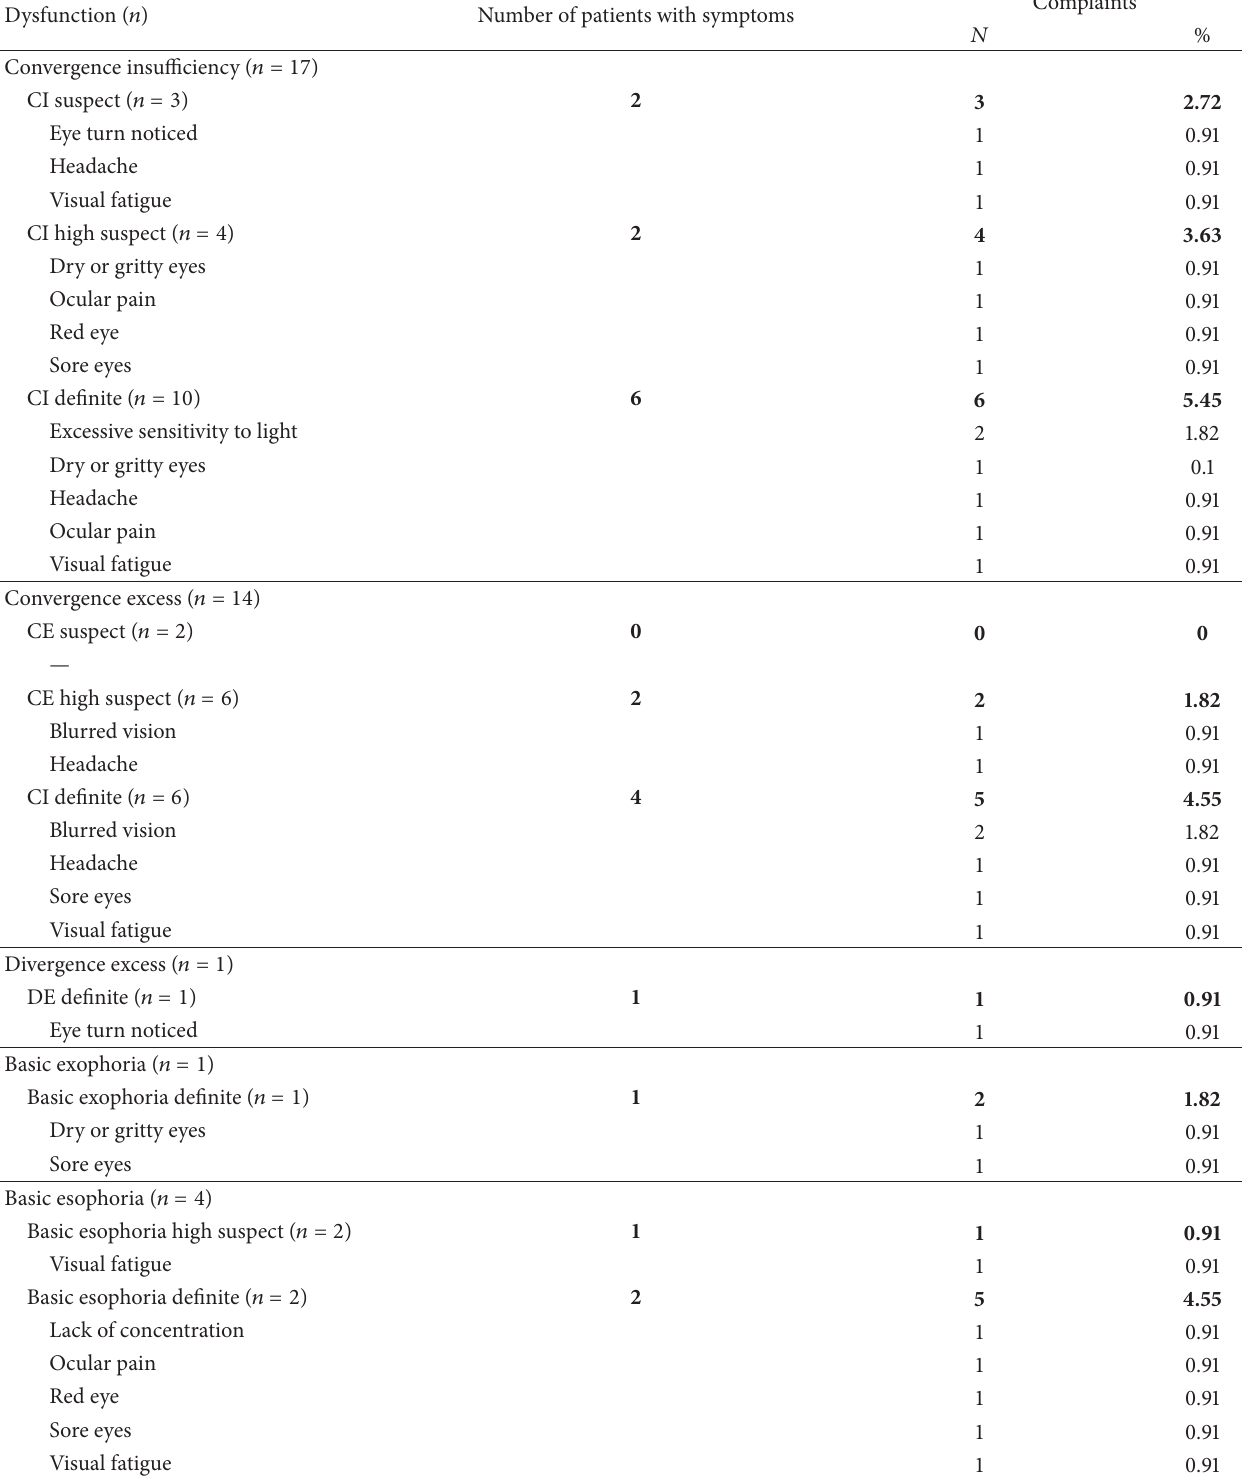
Table 5: Symptoms related to subjects with binocular dysfunctions (CI: convergence insufficiency; CE: convergence excess; DE: divergence